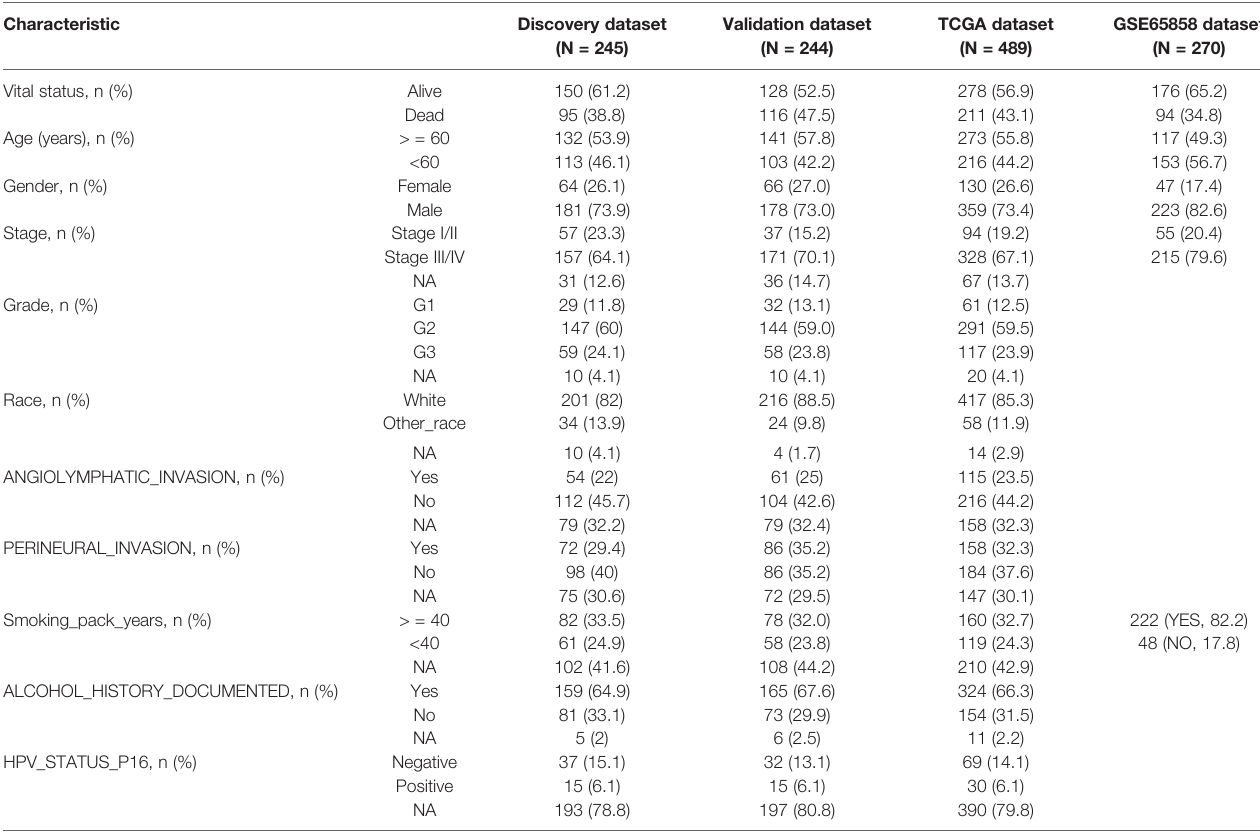
TABLE 1 | Summary of clinical characteristics of three HNSCC patient data sets in the study.